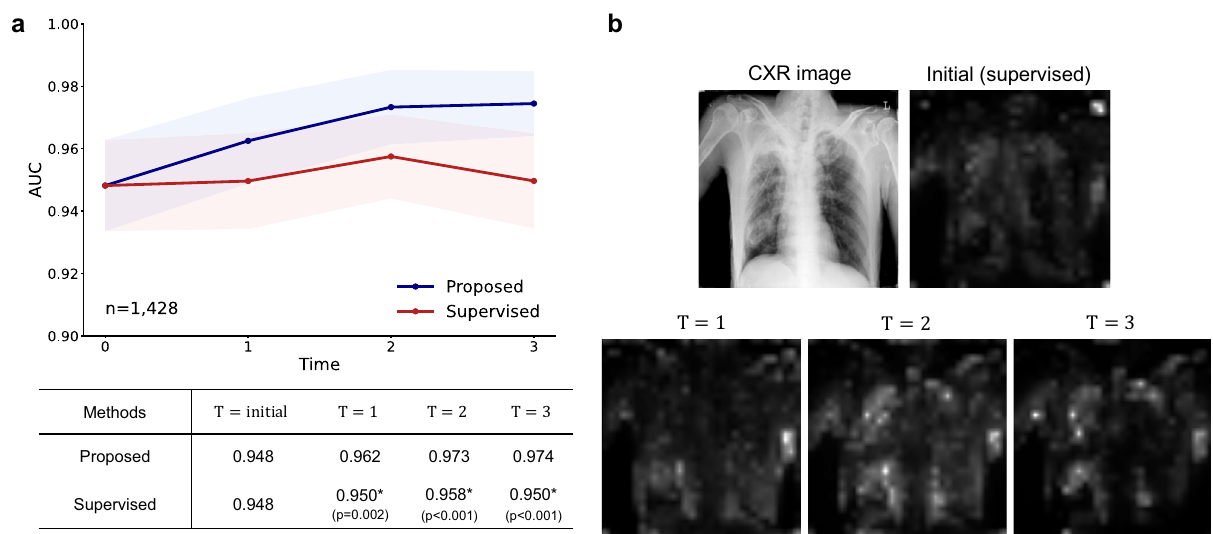
Fig. 3 Tuberculosis diagnosis results with gradually increasing unlabeled data. a Gradually evolving performance with the proposed framework under an increasing amount of data. Compared with the supervised model using the same amount of data with labels, the model trained with the proposed framework without labels showed even better performances. b Gradual attention change of the evolving model for a tuberculosis case. For the exempli fi ed tuberculosis case, the attention of the Vision Transformer (ViT) model gets gradually re fi ned to better catch the target lesions and semantic structures as the model evolves with increasing time T . Data are presented with calculated area under the receiver operating characteristics curves (AUCs) in the study population (center lines) ±95% con fi dence intervals (CIs) calculated with the DeLong's method (shaded areas). The AUCs of the proposed method and the supervised learning method were compared at each time point T with the DeLong test to evaluate statistical signi fi cance, except for the T = initial where the two methods start from the same baseline. * denotes statistically signi fi cant ( p < 0.050) superiority of the proposed framework. All statistical tests were two-sided. CXR, chest X-ray.